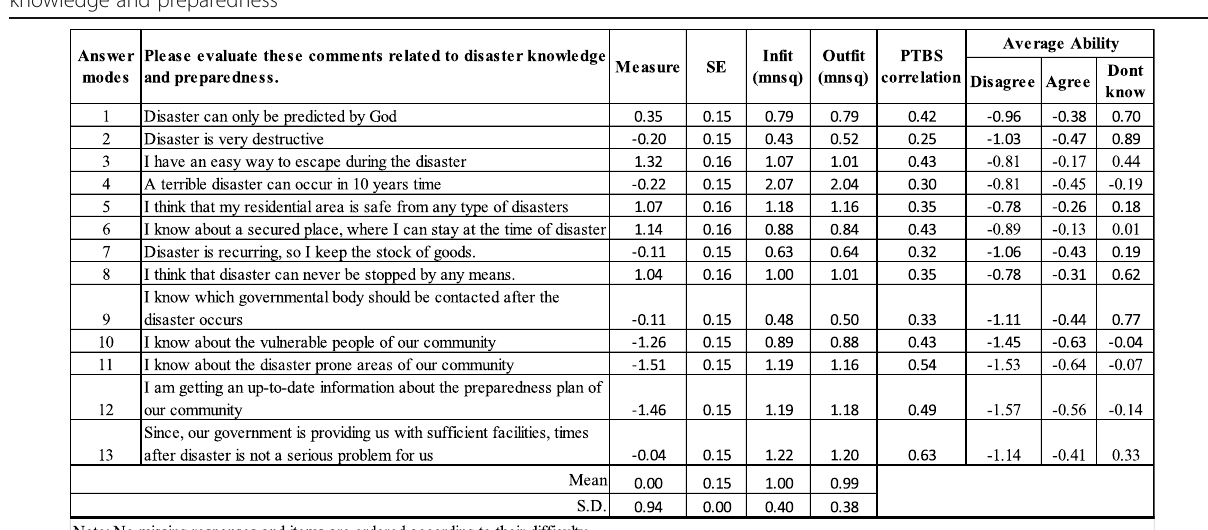
knowledge and preparedness